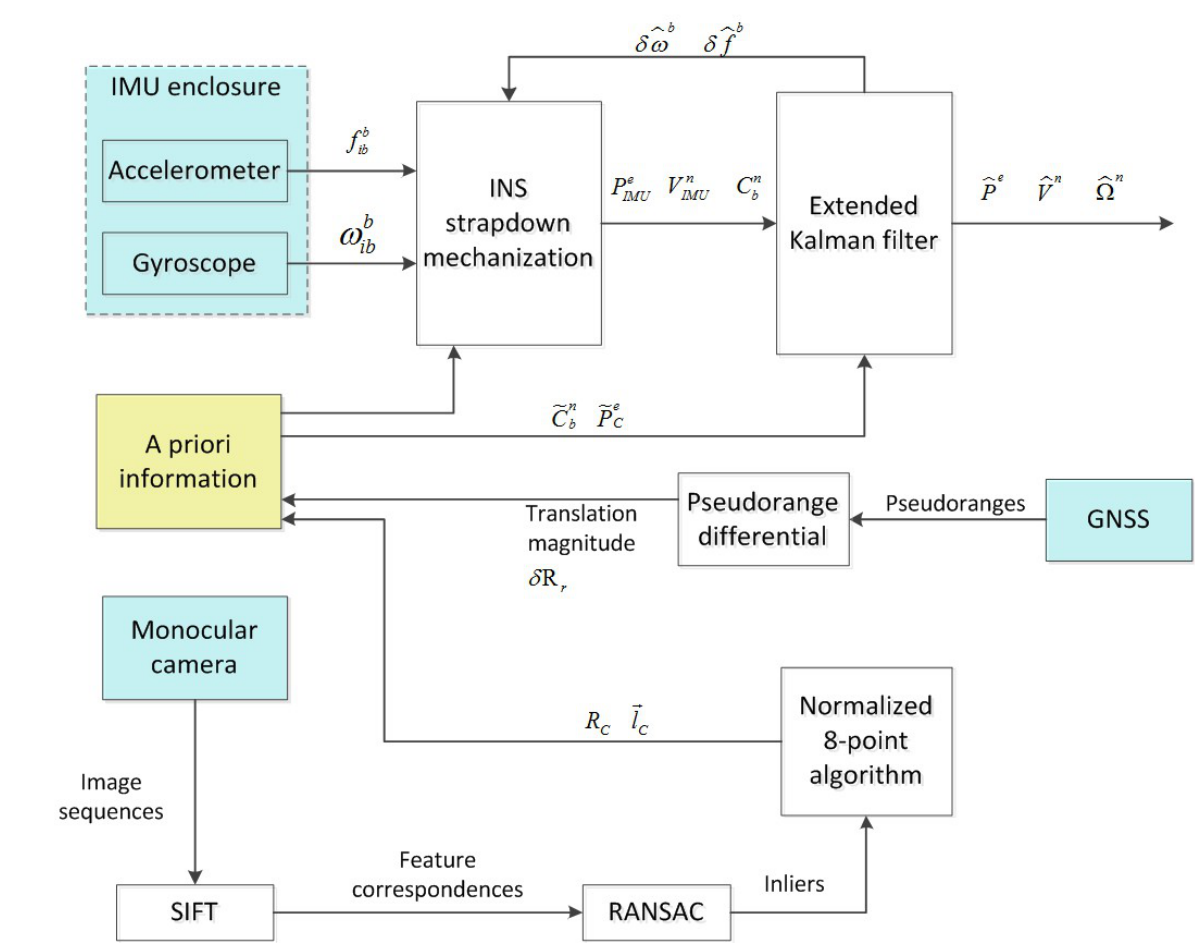
Figure 5. Flowchart of the proposed EKF-based